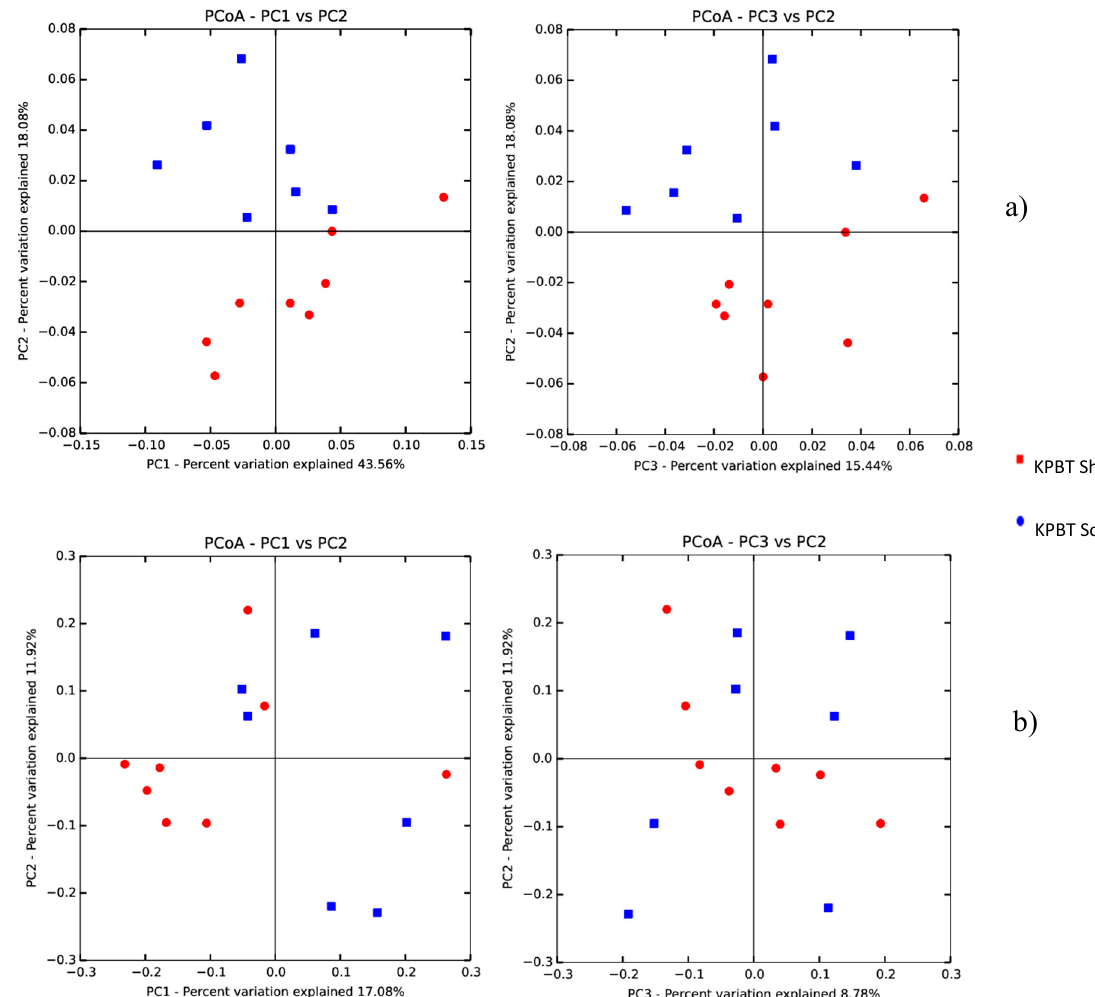
Figure 5. Principal coordinates analysis (PCoA) plots of the weighted ( a ) and unweighted ( b ) Unifrac distance metrics colored by protocols (KPBT So and KPBT Sh) of non-pooled washes. Each dot represents an individual sample from one of the successive washes. All samples were rarefied at 17,463 sequences. Significant di ff erences were observed between each protocol for both weighted and unweighted